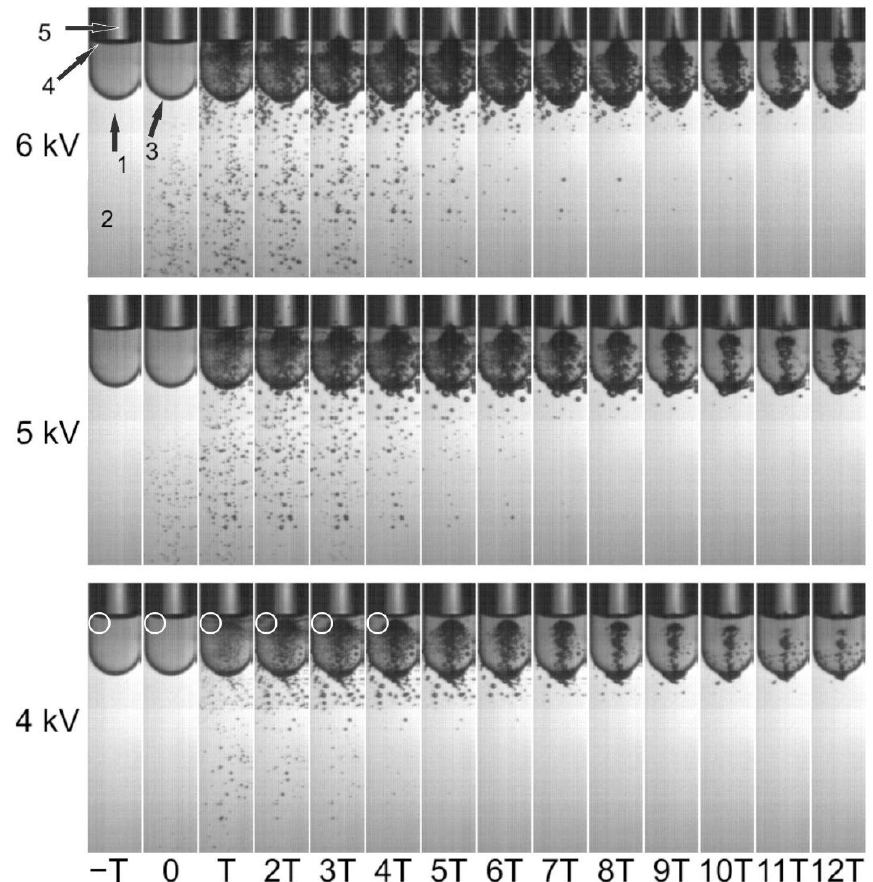
Figure 2. Composition of 14 high-speed images (30,000 fps) showing cavitation bubbles inside a sealed vial containing water and air, after exposure to a single-pulse shock wave, generated at a discharge voltage of 4, 5 and 6 kV. The arrow (1) indicates the direction of the shock wave, which propagated through the water inside the tub (2), penetrated the round-shaped bottom of the vial (3), passed through the water inside the vial and reflected off the water–air interface (4). A diffraction of light (5) from the back side of the vial appears on each image and is irrelevant for the purpose of this study. The first frame where bubbles could be identified was defined as t = 0. In the first six images for 4 kV, circular markings were added to indicate a zone with the smallest cavitation bubbles. ( T = 1/30, 000 s ≈ 33.3 μs).